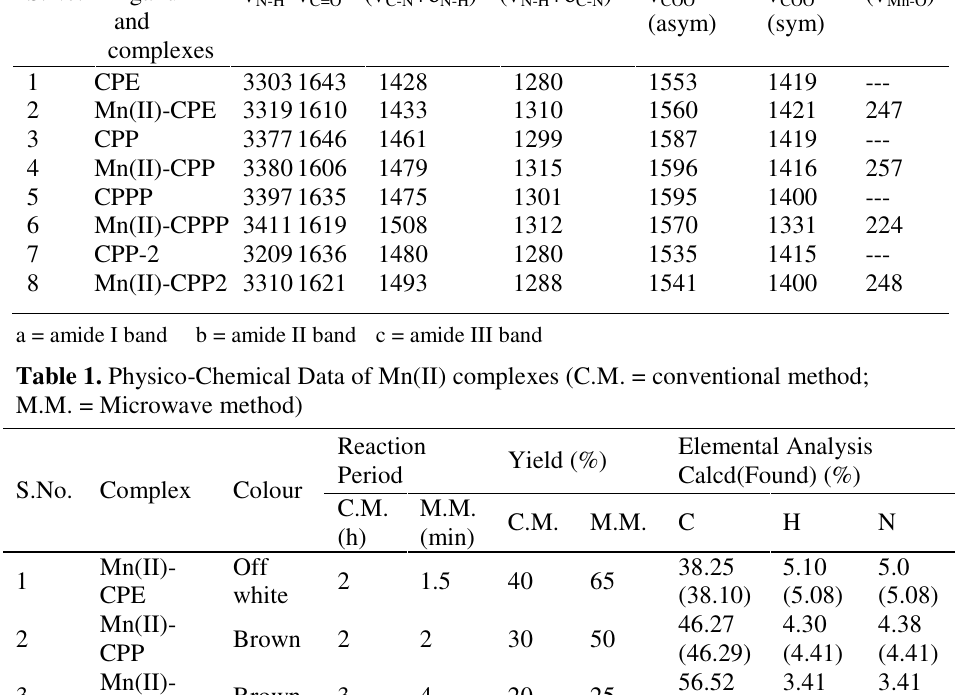
Table 2. IR Spectral assignments of diagnostic bands of ligand and its Mn(II) complexes S.No. Ligand